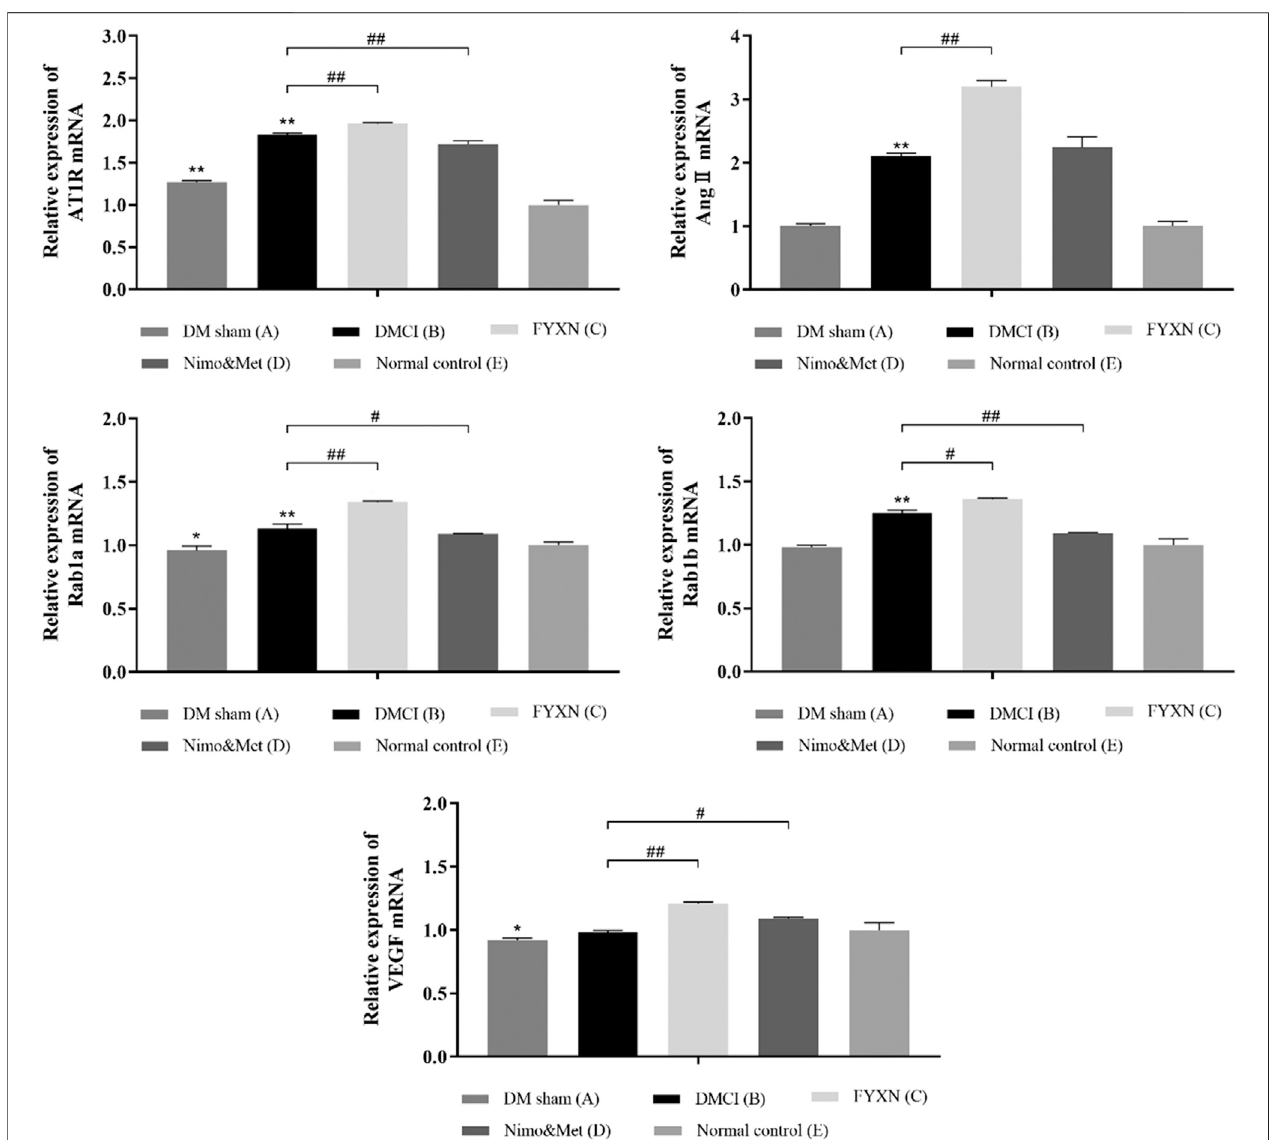
FIGURE 7 | Effects of FYXN treatment on the mRNA levels of AT1R, Ang II, Rab1a, Rab1b and VEGF in ischemic cerebral cortex tissues. Expression levels were detected by RT-qPCR. * p < 0.05, ** p < 0.01 compared with NC group; # p < 0.05, ## p < 0.01 compared with DMCI group.